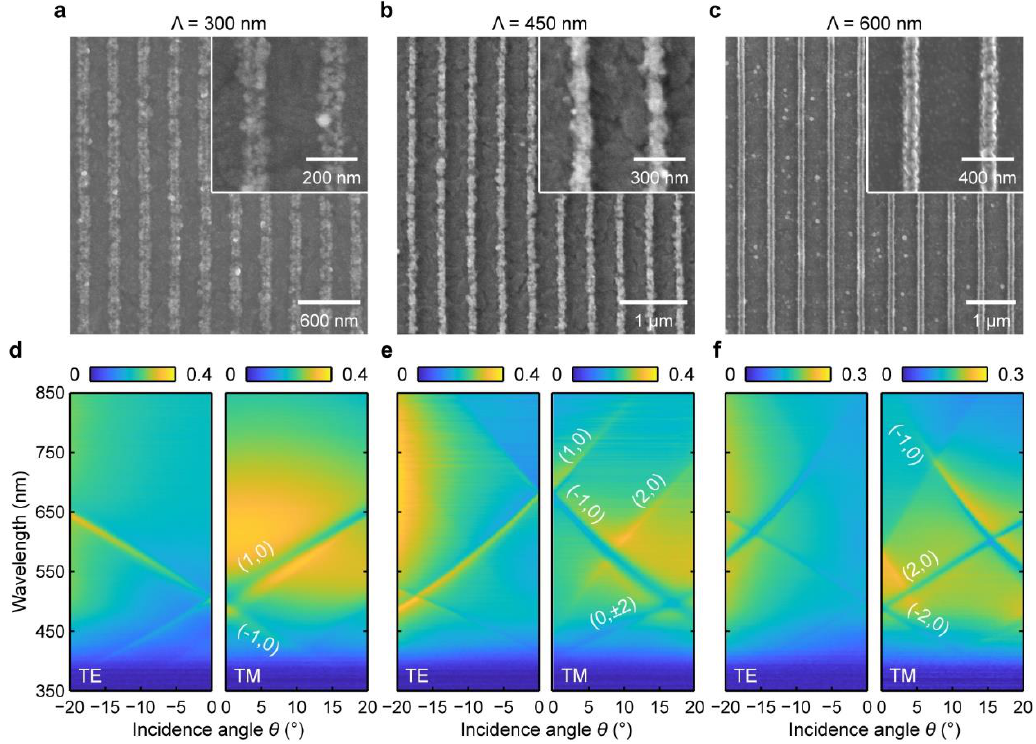
Figure 4. Tuning the waveguide–plasmon coupling behavior by the periodicity of the Ag grating. ( a – c ) SEM images of the Ag gratings with the periodicity of Λ = 300, 450, and 600 nm. ( d – f ) the corre- sponding angle-resolved extinction spectra of the Ag gratings under the TE and TM